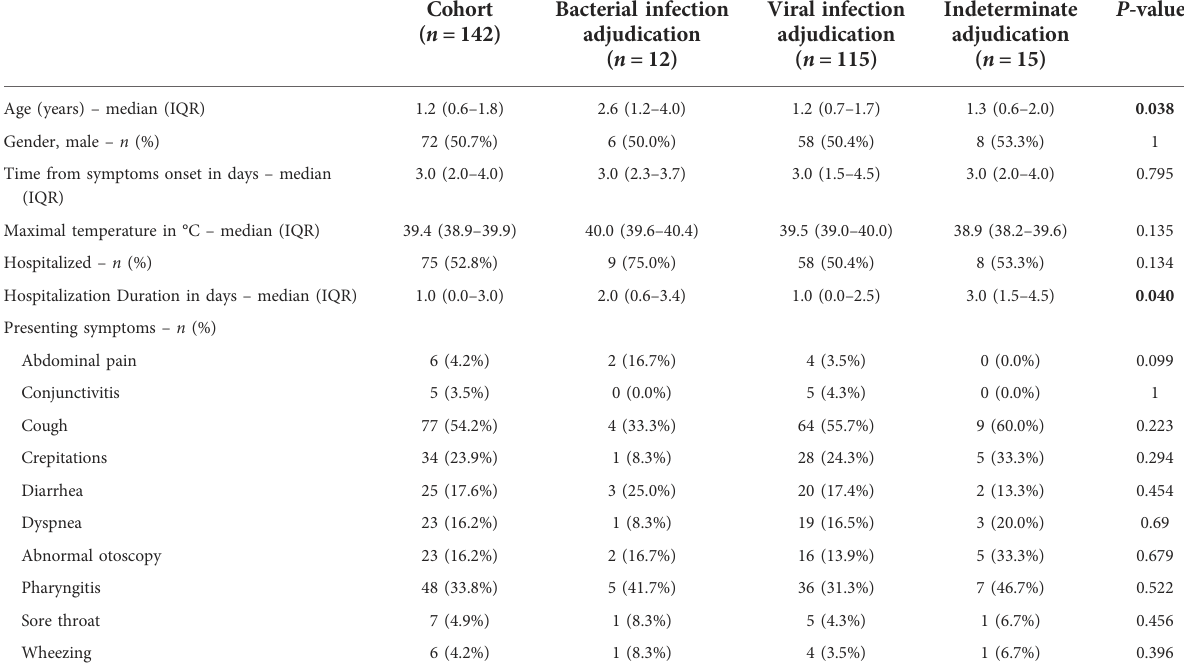
TABLE 1 Patient characterization.